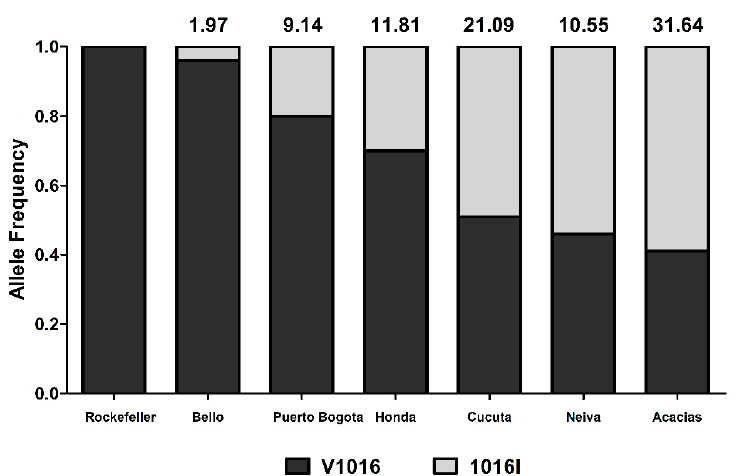
Figure 2. Comparison of allelic frequencies for the 1016I mutation in Aedes aegypti adults from six cities studied in Colombia. The resistance ratio (RR 50 ) value for mosquitoes from each city is shown at the top of each column. The mutation in codon 1016 results in the replacement of valine (V) for isoleucine (I).